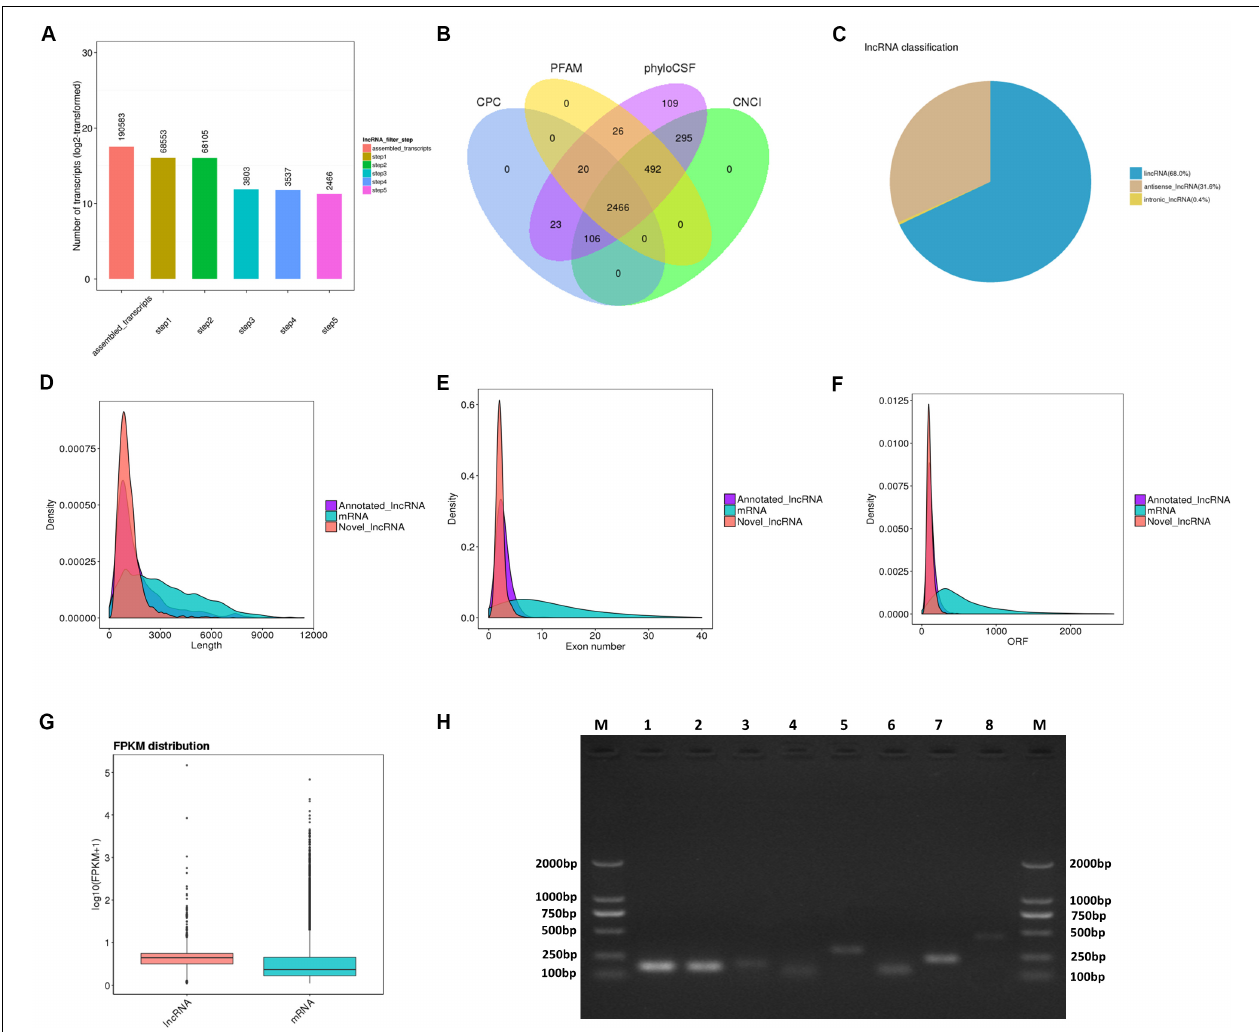
FIGURE 2 | Identification and characterization of lncRNAs in porcine milk exosomes. (A,B) Selection of lncRNAs in porcine milk exosomes by using CPC, PFAM, phyloSCF, and CNCI. (C) Distribution of the three types of lncRNAs. (D) Distribution of lncRNA and mRNA lengths. (E) Distribution of the density of exons in lncRNAs and mRNAs. (F) Distribution of the density of open reading frames in lncRNAs and mRNAs. (G) Expression level of mRNAs and lncRNAs based on log10 (FPKM + 1). (H) Identification of lncRNA PCR product size by agarose gel electrophoresis. M: marker (DL 2000); from 1 to 8, respectively, LNC_002345 (159 pb), LNC_001995 (157 pb), LNC_002300 (177 pb), LNC_002286 (125 pb), LNC_000708 (288 pb), LNC_002290 (134 pb), LNC_001346 (236 pb), LNC_002280 (445